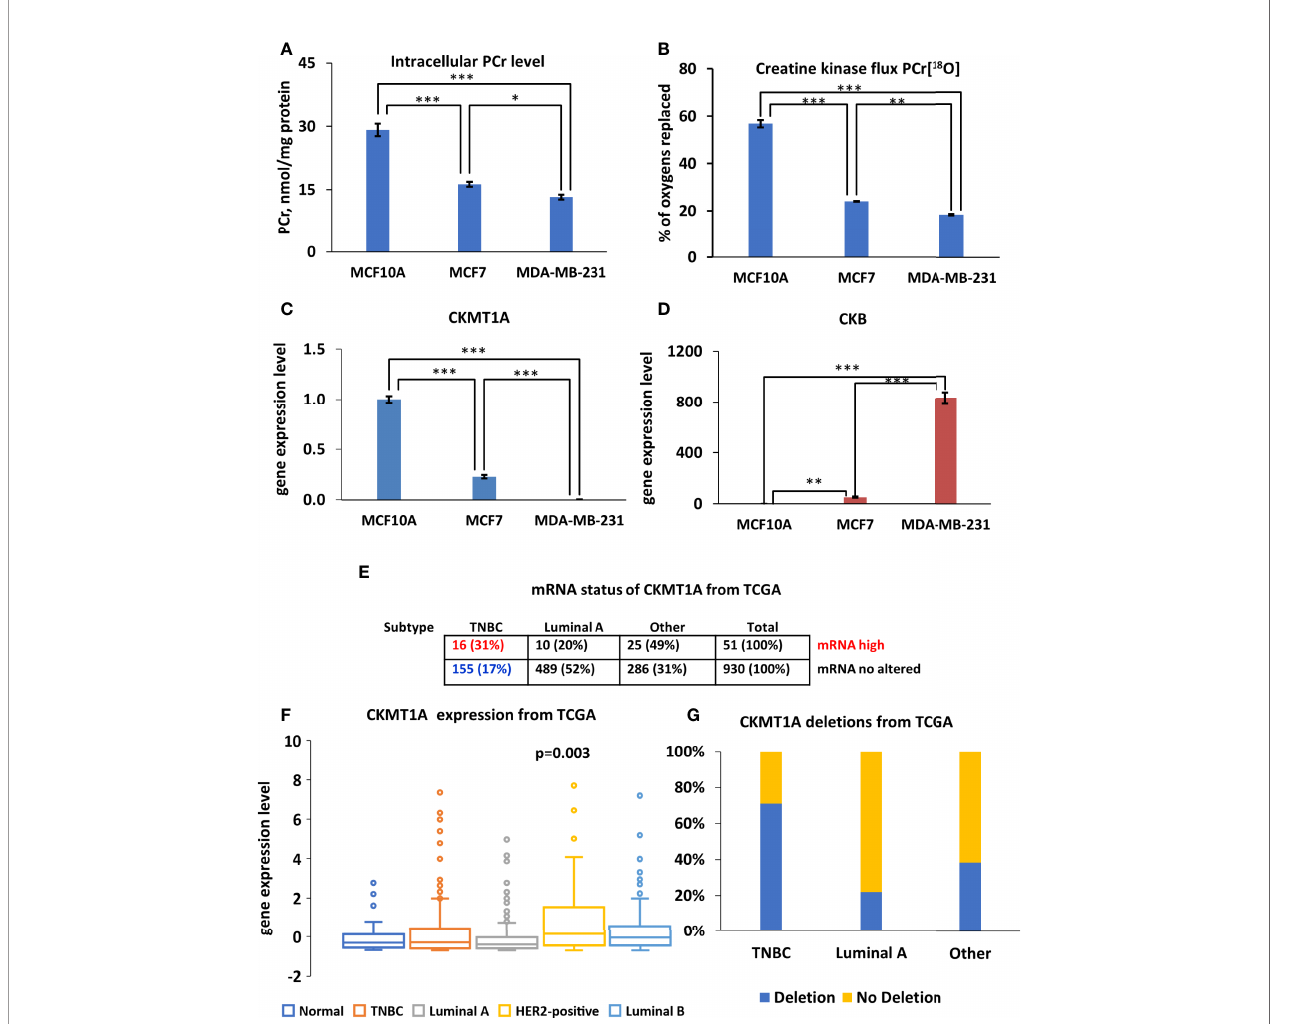
FIGURE 4 | Characterization of creatine kinase (CK) network in Luminal A, Triple-negative breast cancer (TNBC) cells and breast control cells. (A) Comparative analysis of intracellular PCr levels in Luminal A (MCF7), Triple-negative (MDA-MB-231) breast cancer and breast control cells (MCF10A). (B) 18 O-metabolic labeling of PCr[ 18 O] re fl ecting CK fl ux. Expression pattern of (C) CKMT1A (fold change of the mRNA level) and (D) CKB (fold change of the mRNA level). (A – D) Data are presented as mean ± SEM (ANOVA followed by Holm-Sidak test n=3-5). *, ** and *** indicate a statistical signi fi cant difference between the mean values; p < 0.05, p < 0.01 and p < 0.001, respectively. The Cancer Genome Atlas (TCGA) database was utilized to analyze CKMT1A (E) mRNA status (F) expression patterns (ANOVA followed by Holm-Sidak test) and (G) CKMT1A gene deletion patterns in different breast cancer subtypes. PCr –